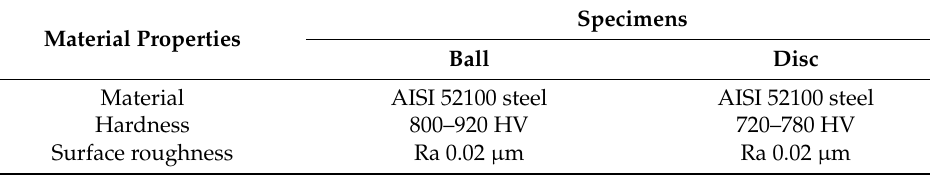
Table 1. MTM specimen materials and tests conditions.